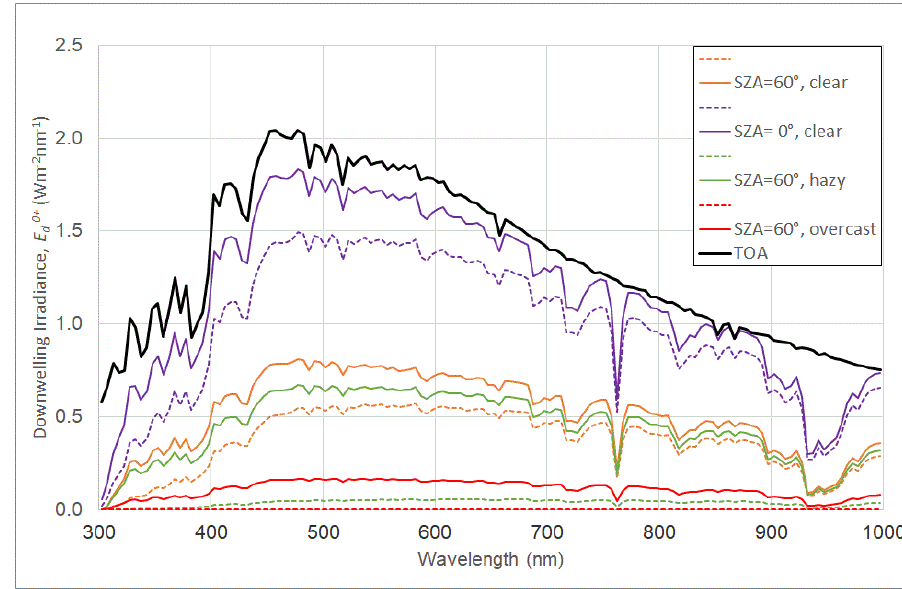
Figure 2. 𝐸 𝑑0+ for four combinations of Sun zenith angle (SZA) and atmospheric conditions, averaged over 5-nm bands. Solid colored lines are total 𝐸 𝑑0+ ; dashed lines are the corresponding direct component. The solid black line is the band-averaged extraterrestrial solar downwelling irradiance for comparison. Redrawn from [7].